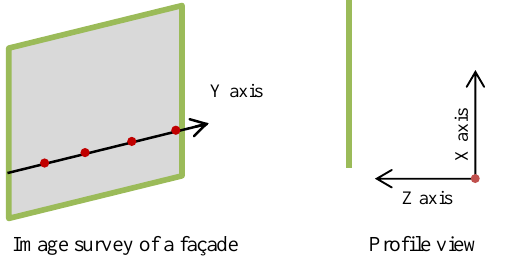
Figure 8: “OrthoCylindric” geometry: optimization of the “cartographic” 3D reconstruction geometry (camera positions are shown as small red circles)